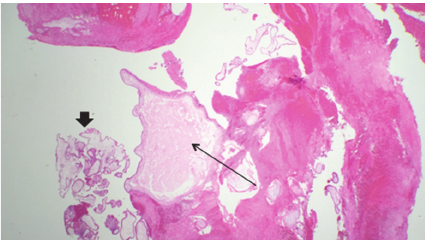
Figure 3: Low power magnification (2x) of the partial hydatidiform mole. Thin arrow: large edematous villus with central cistern formation. Thick arrow: smaller